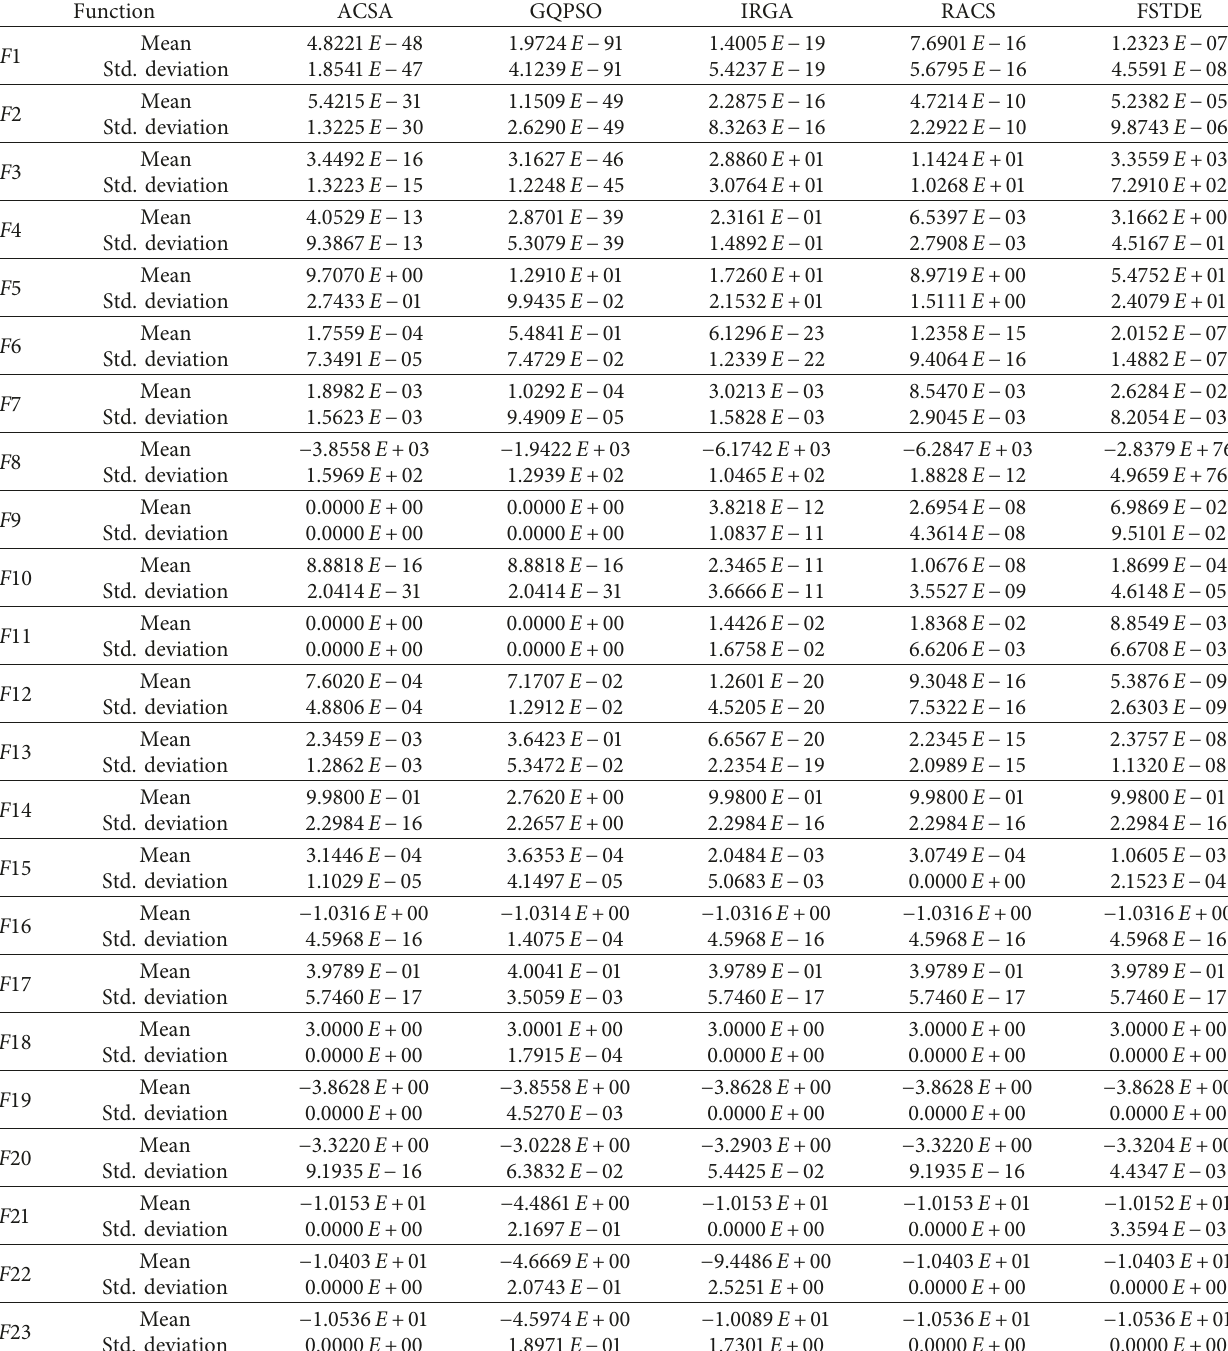
Table 6: Comparison of optimization results from advanced